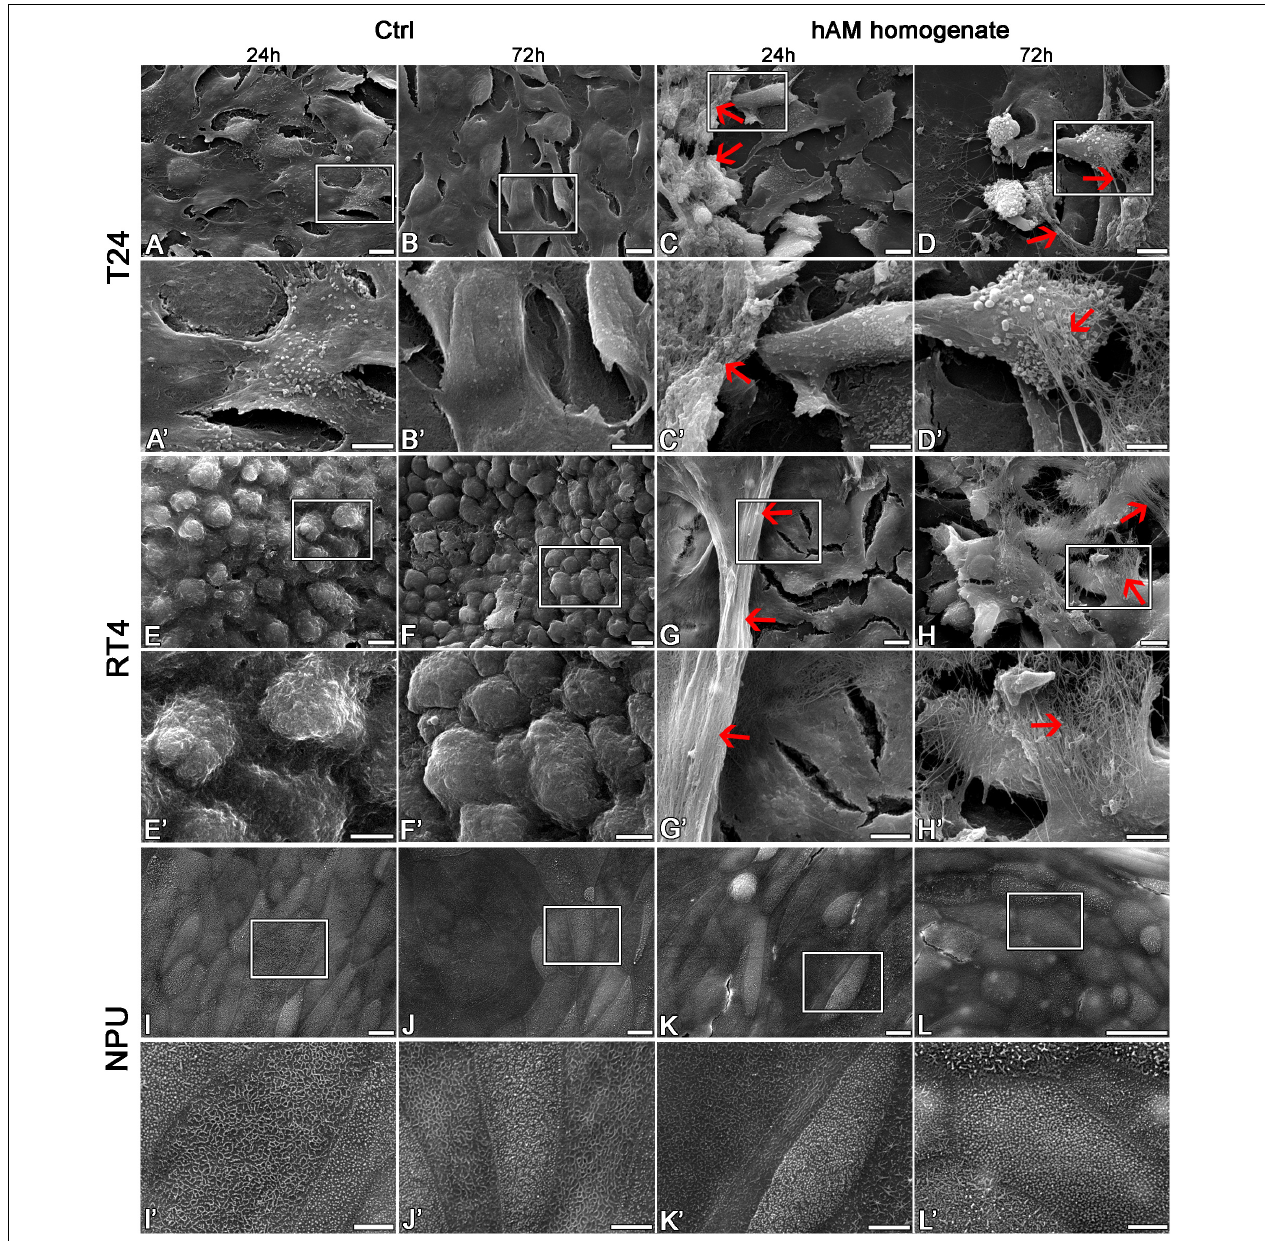
FIGURE 7 | The hAM homogenate adheres to the surface of T24 and RT4 cells. (A–B ’ ) The T24 cells incubated in culture medium for 24 or 72 h had mesenchymal morphology and there were large intercellular spaces between the cells. (C–D ’ ) The 24- and 72-h incubation in hAM homogenate did not significantly affect the morphology of T24 cells. The hAM homogenate adhered to the surface of T24 cells and a large portion of cells were covered with it. (E–F ’ ) The RT4 cells incubated in culture medium for 24 or 72 h had epithelial morphology and were well connected. (G–H ’ ) The 24- and 72-h incubation in hAM homogenate did not significantly affect the morphology of RT4 cells. The hAM homogenate adhered to the surface of RT4 cells and a large portion of cells were covered with it. (I–J ’ ) The NPU cells incubated in culture medium for 24 or 72 h retained the apical topography of well-differentiated normal urothelial cells. The apical plasma membrane appeared as ropy and rounded ridges, and rarely microridges. (K–L ’ ) The 24- and 72-h incubation in hAM homogenate did not significantly affect the morphology of NPU cells and the hAM homogenate did not adhere to the surface of NPU cells. All data shown here were obtained from at least three independent replications of experiments using three biological samples of hAM; each experiment was performed in 1–2 technical repeats for each condition. Red arrows–hAM homogenate. Frames in panels (A–L) mark enlarged areas shown in panels (A ’ –L ’ ) . Scale bars: (A–L) 10 µ m, (A ’ –L ’ ) 5 µ m.